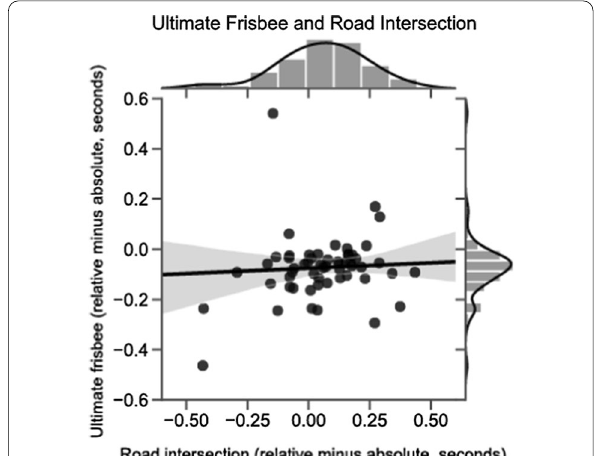
Fig. 2 Correlation between reference frame preference across road intersection and ultimate frisbee tasks. Preference for a relative versus absolute reference frame was operationalized by the difference in reaction time between each trial type. Thus, negative values refer to faster reaction time on relative compared to absolute trials. As the scatter plot shows, there was no correlation between reference